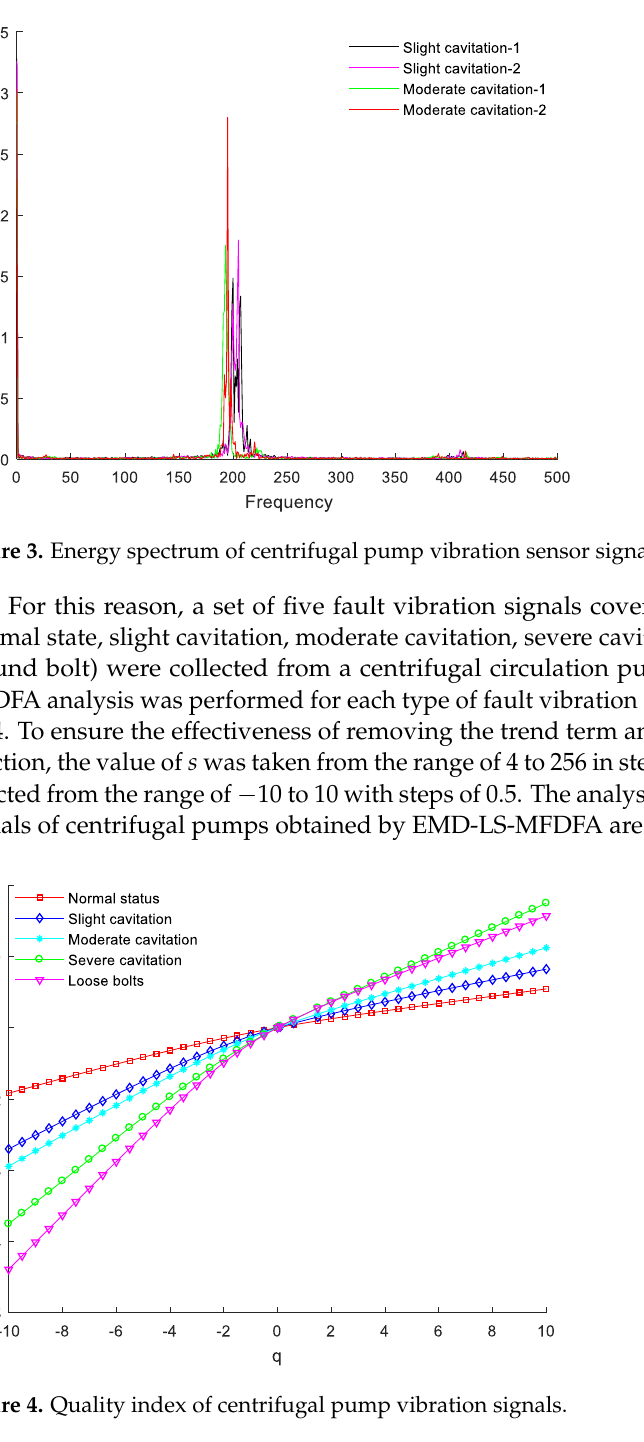
Figure 5. Generalized Hurst exponent of centrifugal pump vibration signals. Figure 6. Multi-fractal spectrum of centrifugal pump vibration signals.